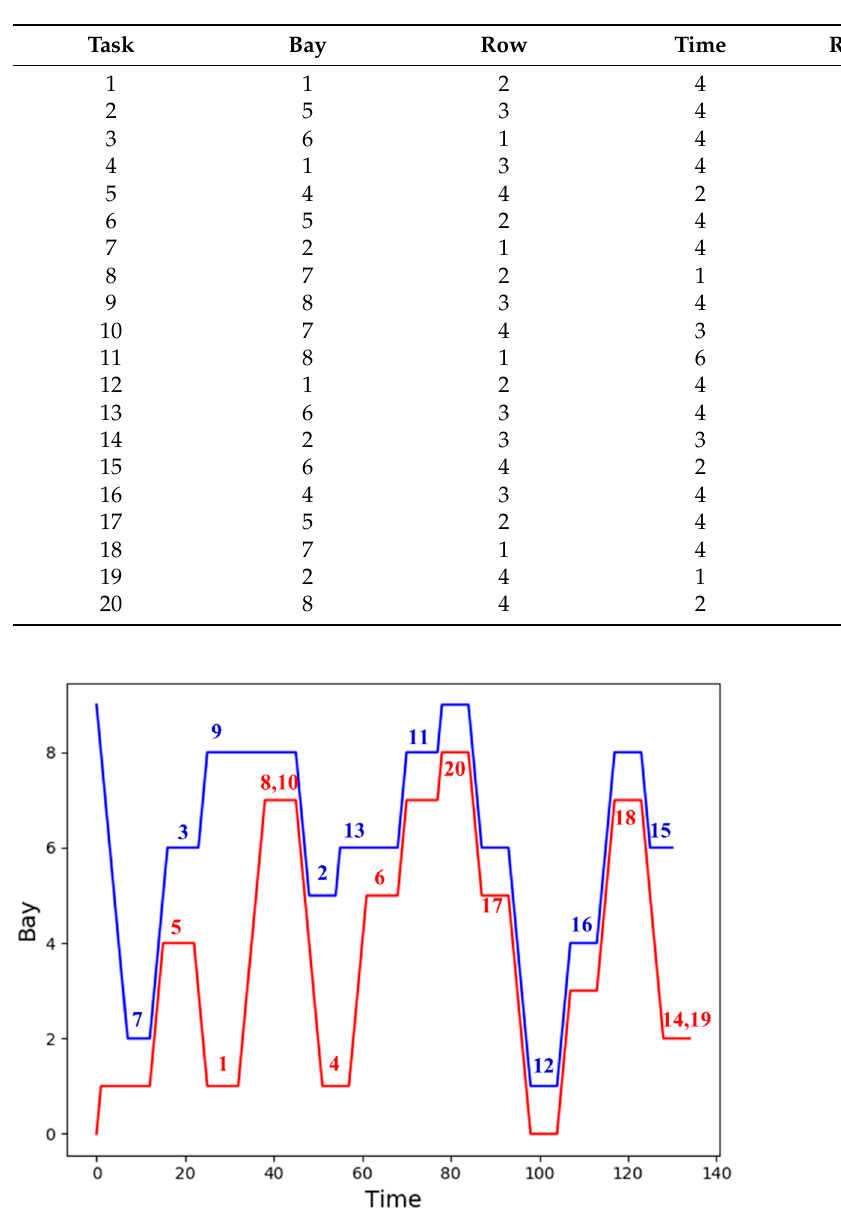
Table 5. Initial tasks.